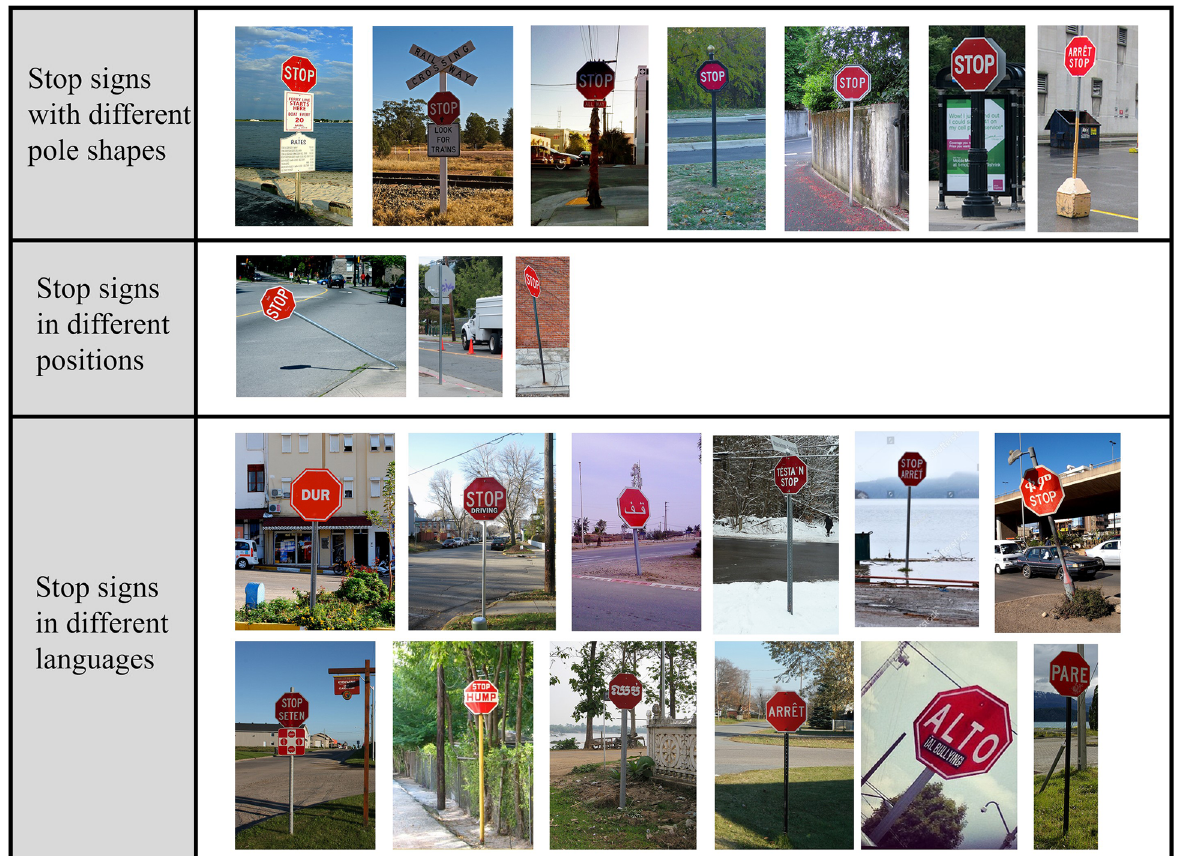
Fig. 7 Photos of various stop signs in different forms and languages available from the Microsoft COCO